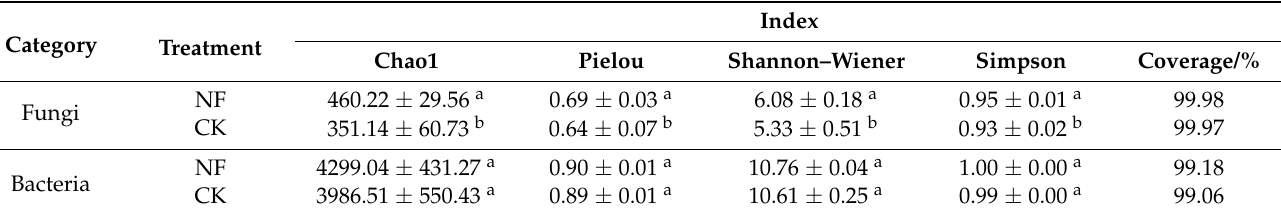
Table 2. Changes in microbial diversity under main land-use types (mean ± SD).